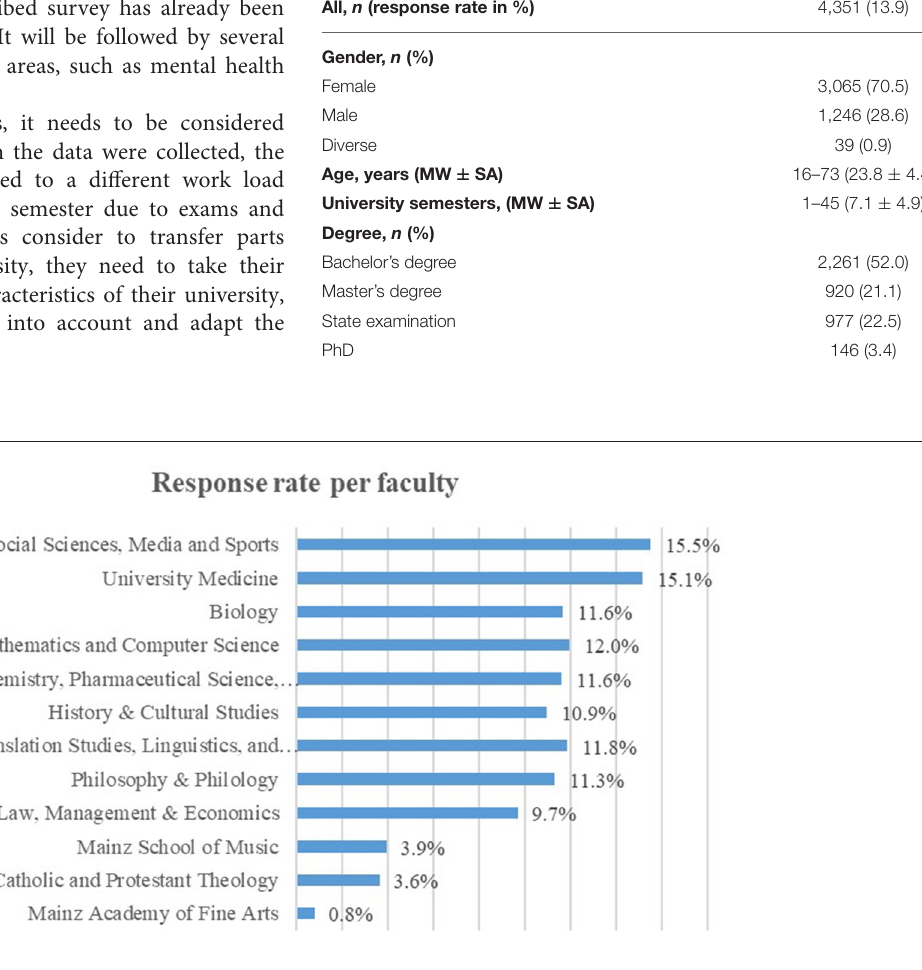
FIGURE 2 | Survey response rate distributed for faculty.